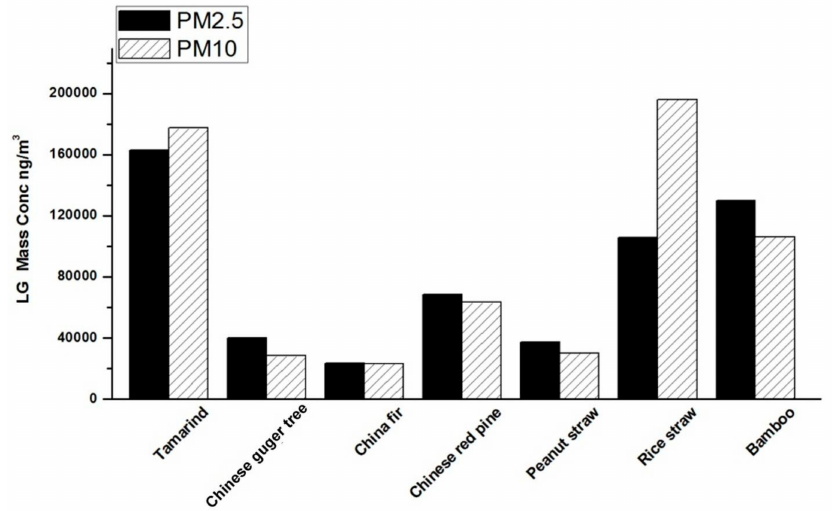
Figure 3. Levoglucosan concentrations in PM 10 and PM 2.5 emitted by combustion of di ff erent biofuel species.